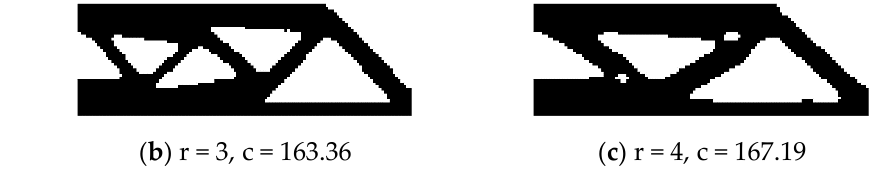
Figure 11. Optimization results of the SIMP-GA method.